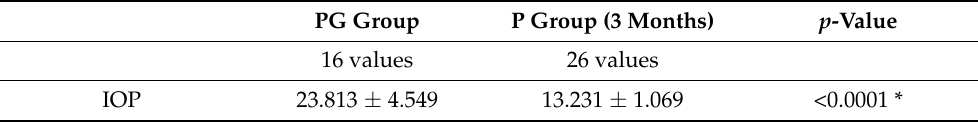
Table 6. p value for IOP at three months in both